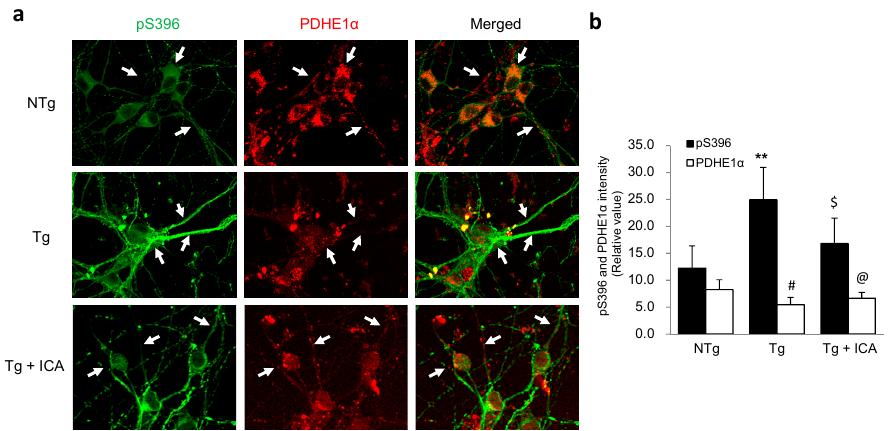
Figure 6. Double-labeling analysis of phosphorylated tau pS396 and PDHE1 α in neurons treated with icariin. ( a ) NTg neurons showed a faint staining of pS396 in the neurites where PDHE1 α expression was abundant (white arrows). In Tg cells, the strong pS396 staining was correlated with a weaker signal of PDHE1 α immunoreactivity (white arrows). In icariin-treated Tg cells, the expression of PDHE1 α was increased in the neurites, accompanied with a downregulation of pS396 (white arrows); ( b ) Quantification of pS396 and PDHE1 α immunoreactivity showed a higher expression of pS396 and a lower expression of PDHE1 α in Tg neurons relative to NTg cells, which was reversed by treatment with icariin. Bar graphs (means ± SD) represented three independent experiments. ** p < 0.01 vs. pS396 level in NTg neurons; # p < 0.05 vs. PDHE1 α level in NTg neurons; $ p < 0.05 vs. pS396 level in Tg neurons; @ p < 0.05, vs. PDHE1 α level in Tg neurons. Scale bars in ( a ) = 30 μ m.